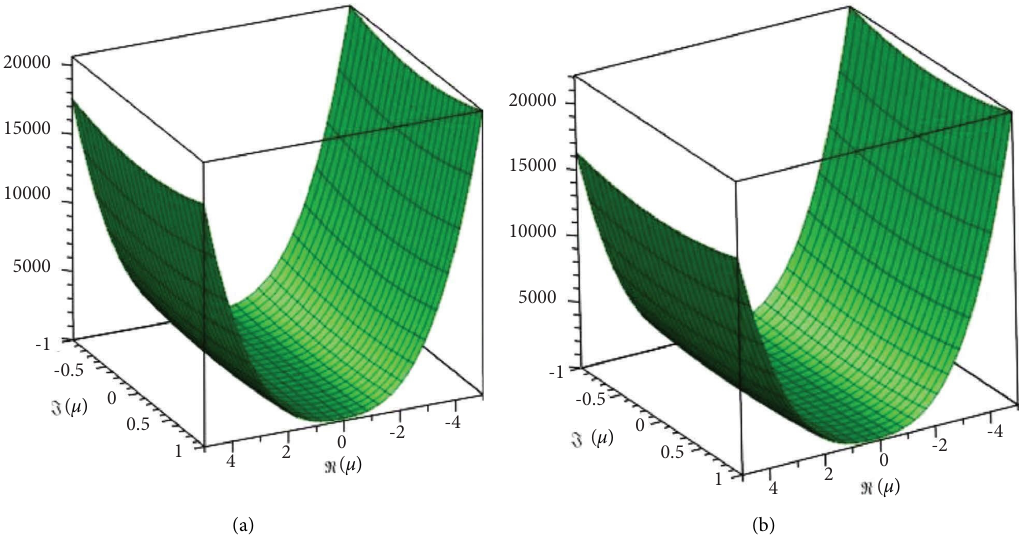
Figure 5: For varying Z and η values, the infected cases is increasing gradually (a) B